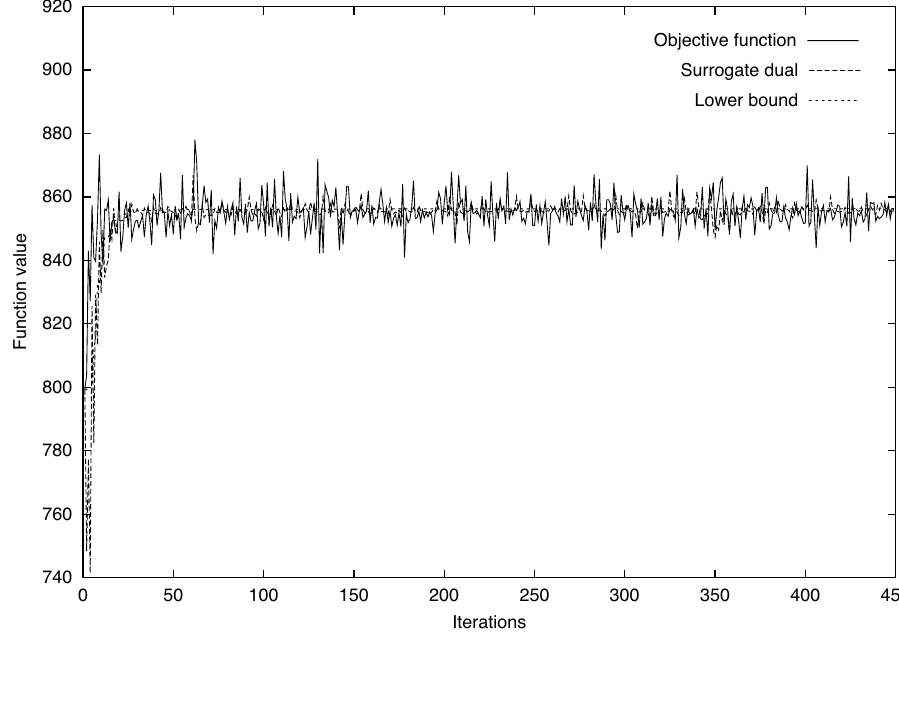
Fig. 1 Transition of objective function, surrogate dual func- tion, and lower